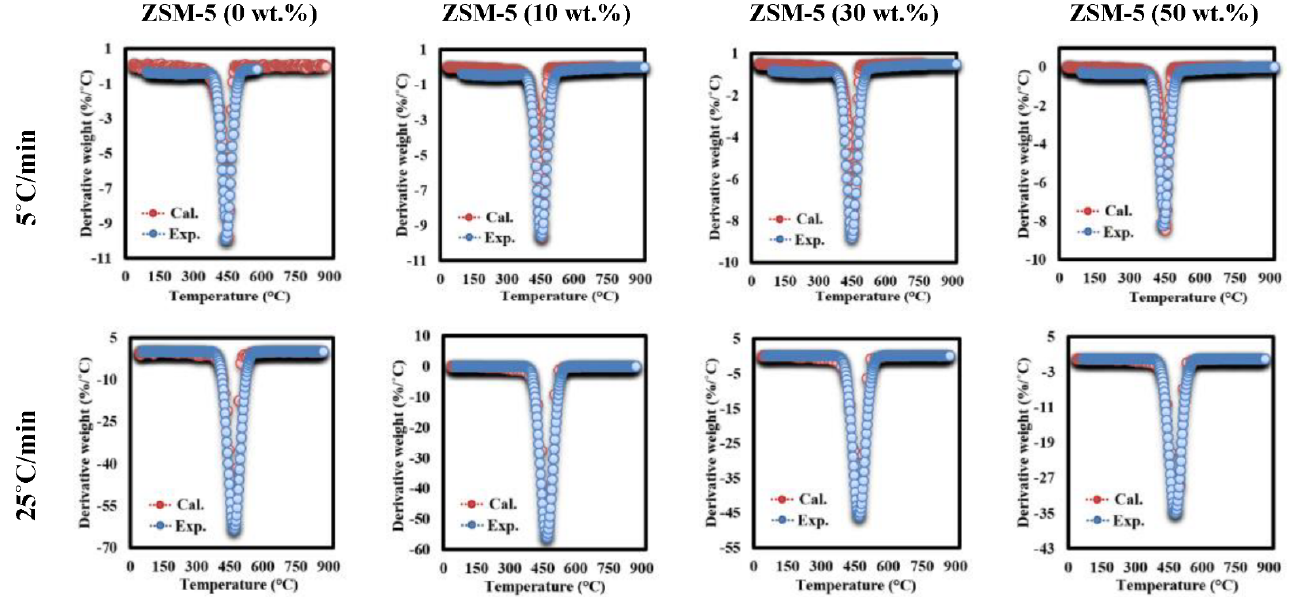
Figure 9. Fitting of DTG experimental and calculated data for MFPW and ZSM-5 (30%)/MFPW samples at 5 and 30 °C/min.